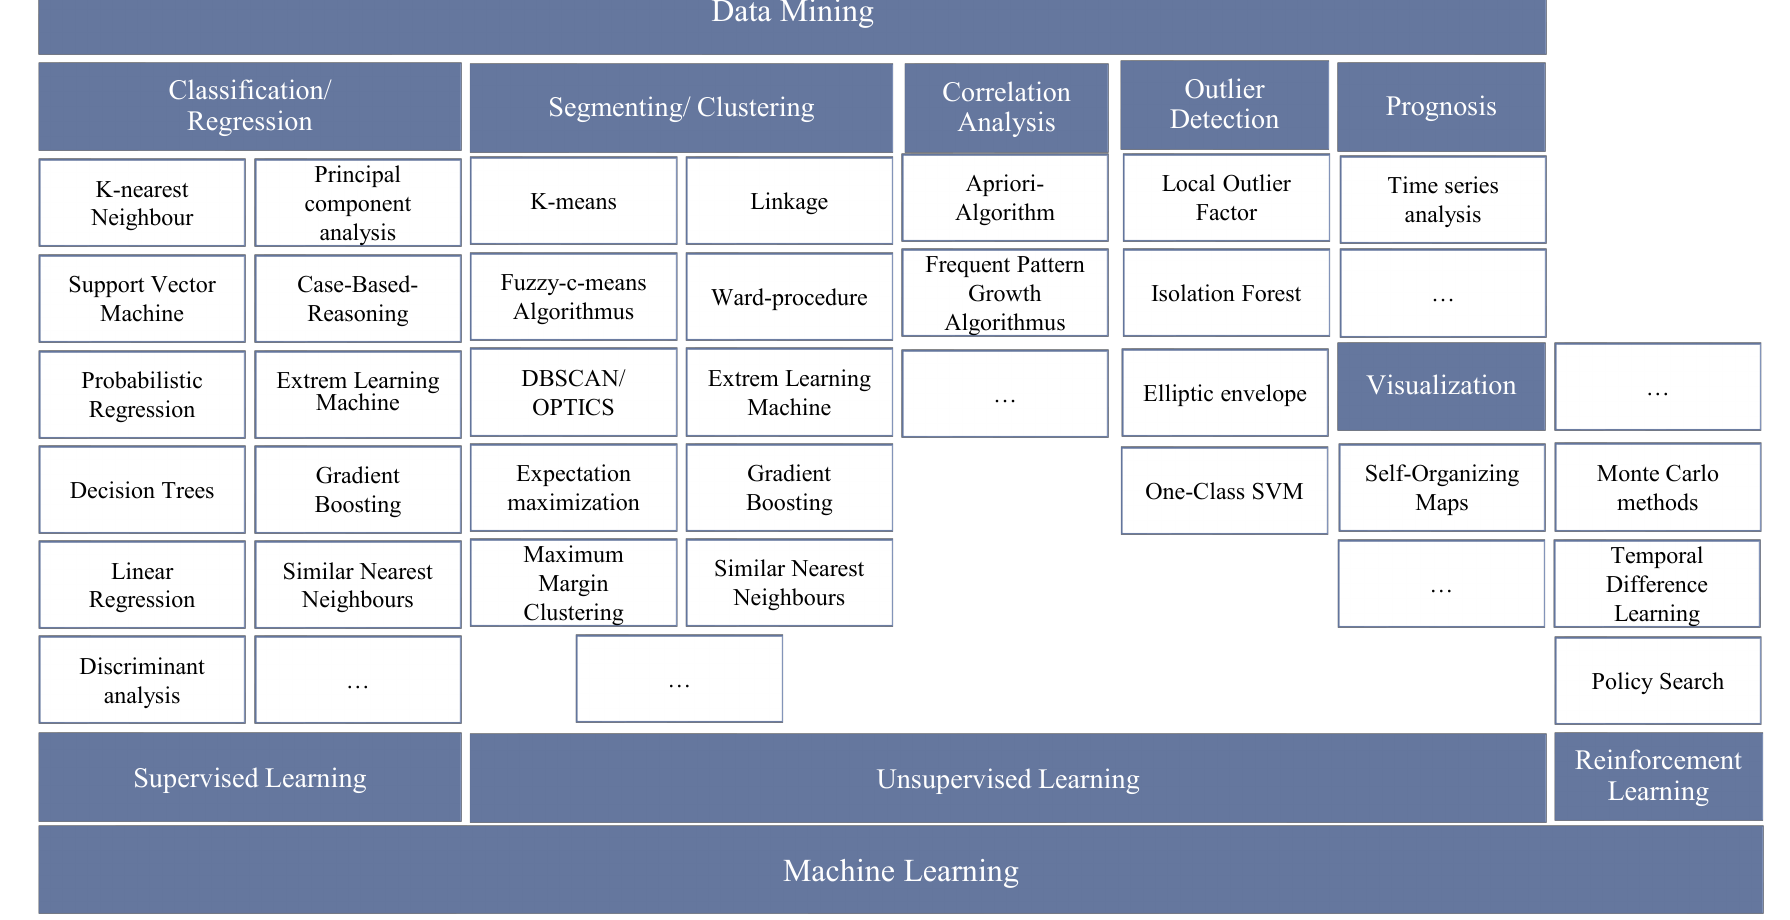
Figure 2. Overview of Data Mining and Machine Learning